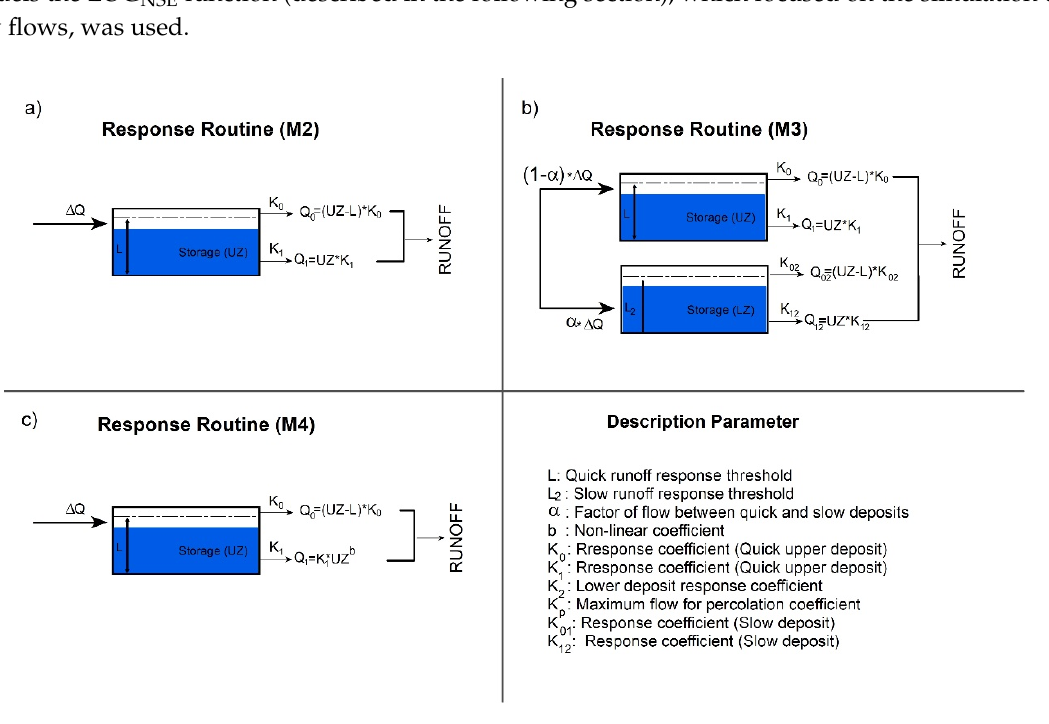
Figure 3. Additional adapted configurations of conceptual groundwater models, including a description of their parameters and main equations. ( a ) M2 model: one reservoir with two outlets; ( b ) M3 model: combination of two parallel reservoir with two outlets each one; ( c ) M4 model: one reservoir with two non-linear outlets.